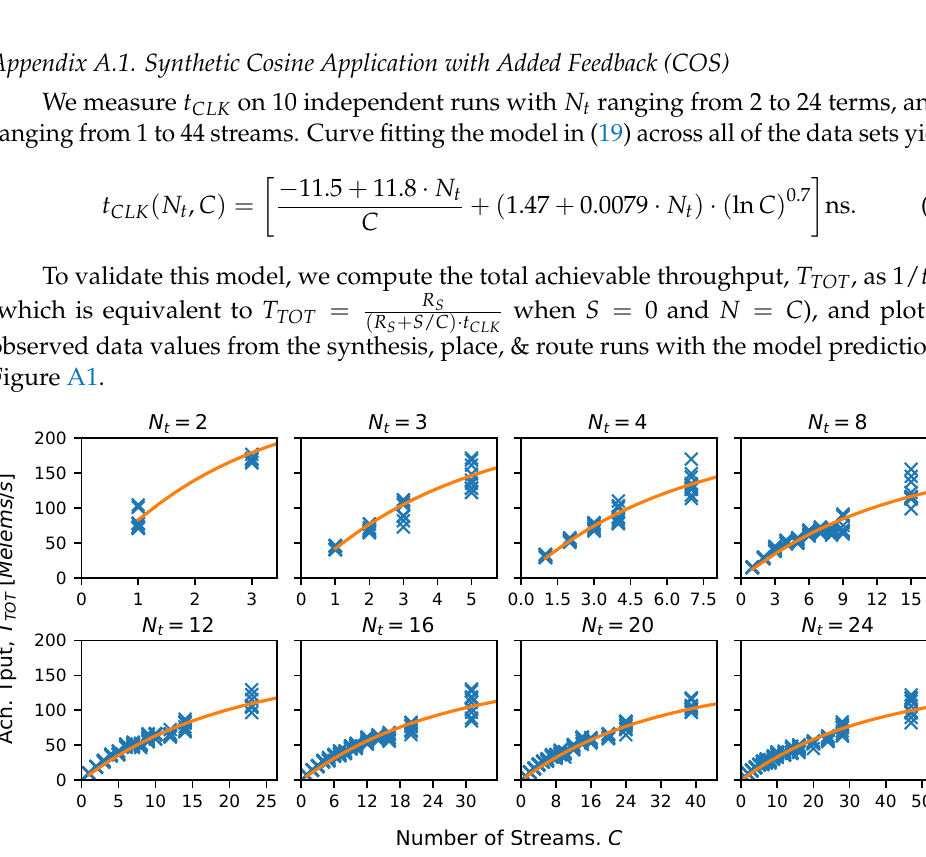
Figure A1. Calibrated total achievable throughput plot of the virtualized cosine application. The parameters used are N = C and S = 0 (i.e., no secondary memory). Data points are from 10 tool flow